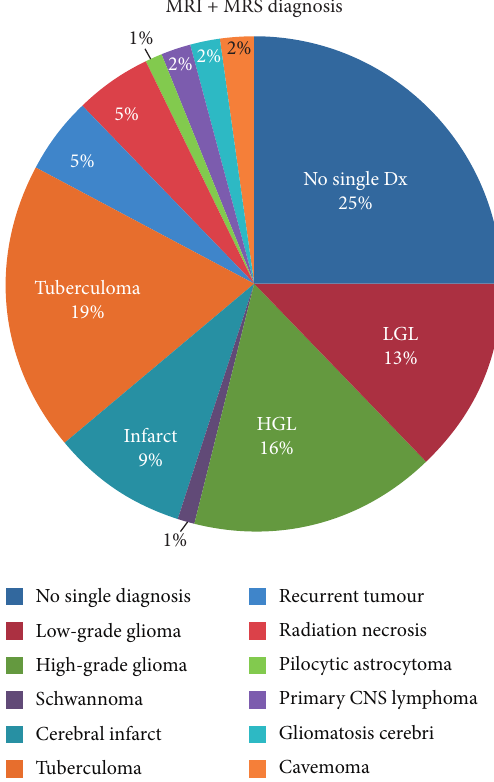
Figure 2: MRI +MRS diagnosis.